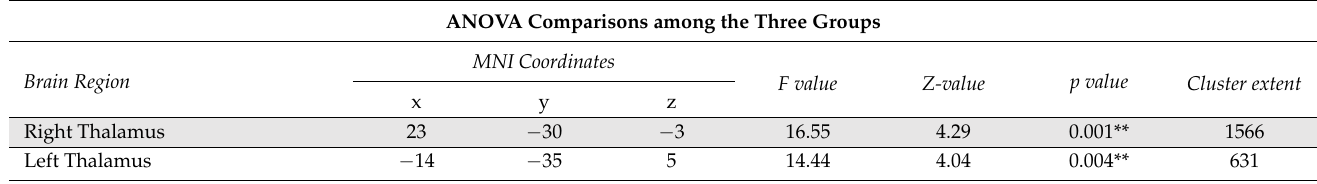
Table 5. Structural covariance analysis. Seed region: Right